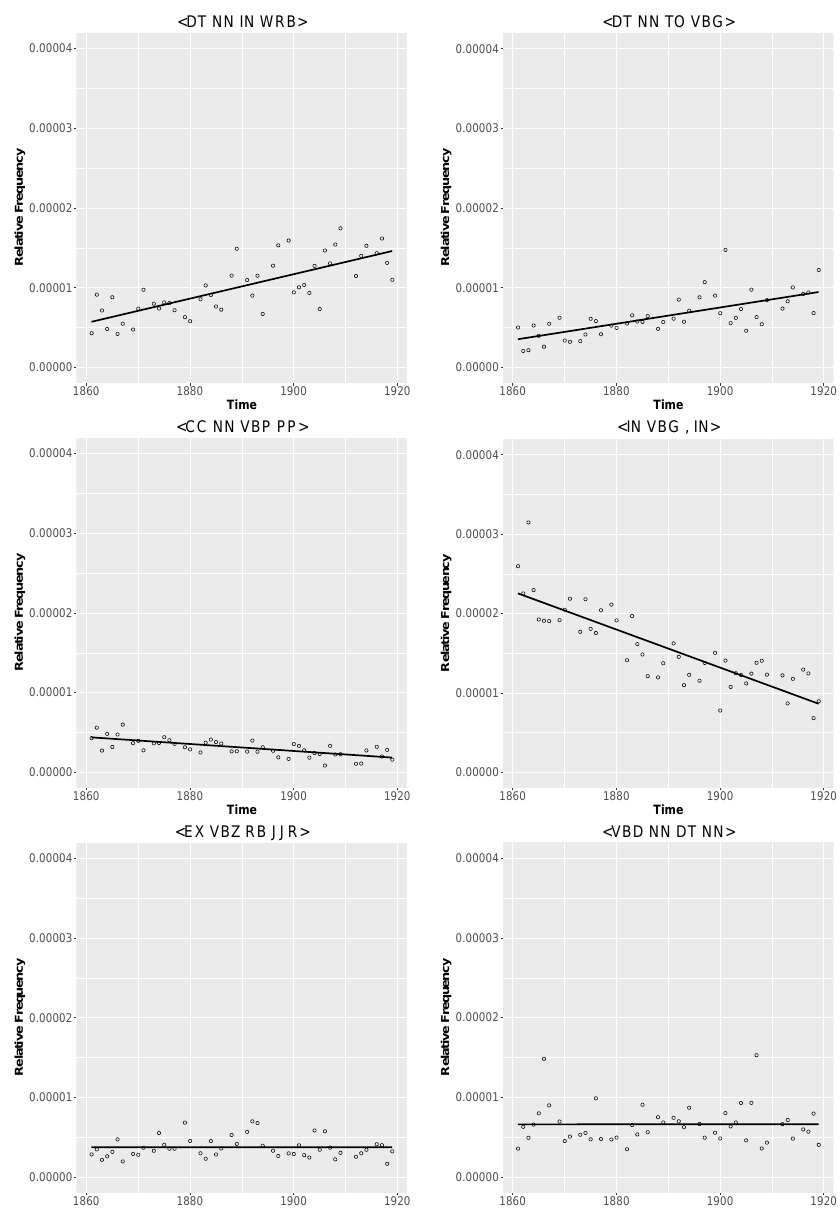
Figure 5: Reference corpus: relative frequency of several syntactic tetragrams, exhibiting ‘increase’, ‘decrease’, or ‘no perceptible change’ over time